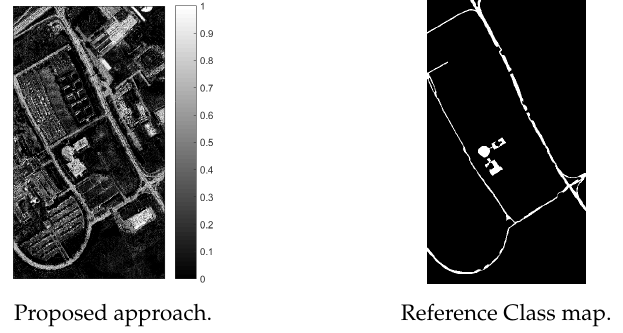
Figure 25. Comparison of Asphalt and Bitumen abundance map and binary reference map for Pavia.